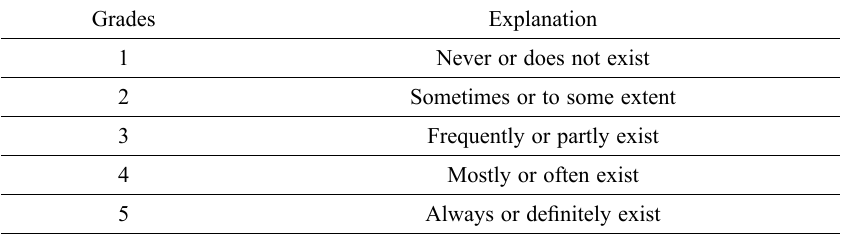
Table 2. The explanation of grades in maturity assessment process